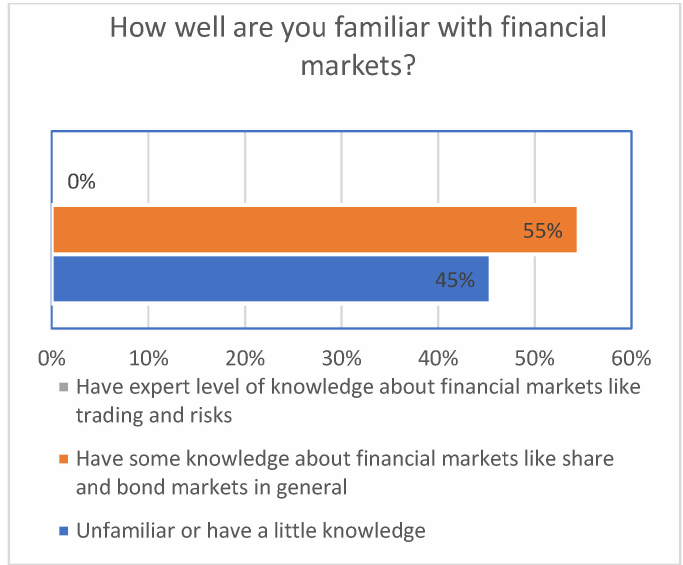
Figure 10. Respondents’ knowledge of financial